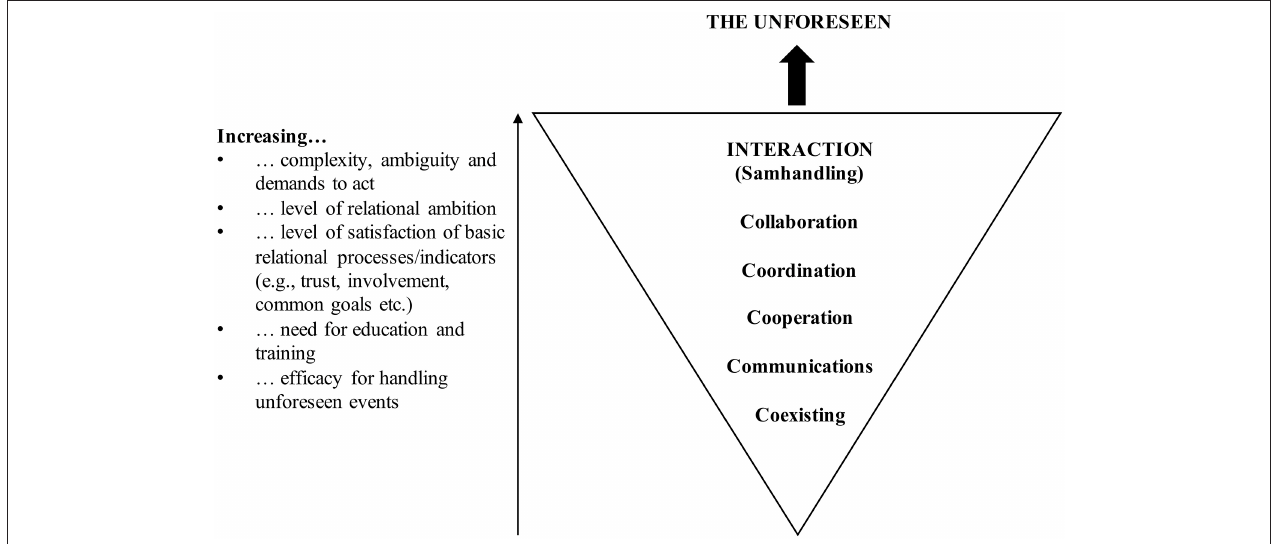
FIGURE 1 | The relation between characteristics and requirements of the unforeseen, interaction and other relational forms, based on (Torgersen and Steiro, 2018, p. 46). Interaction corresponds with the Norwegian term “samhandling”.